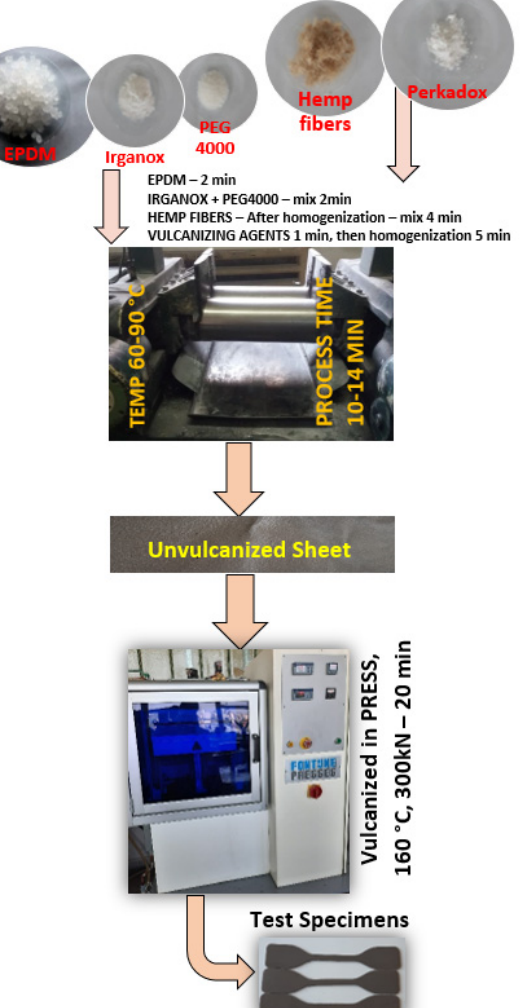
Scheme 1. Schematic illustration for the preparation of the EPDM-based composites. Table 1. Composite formulations a .